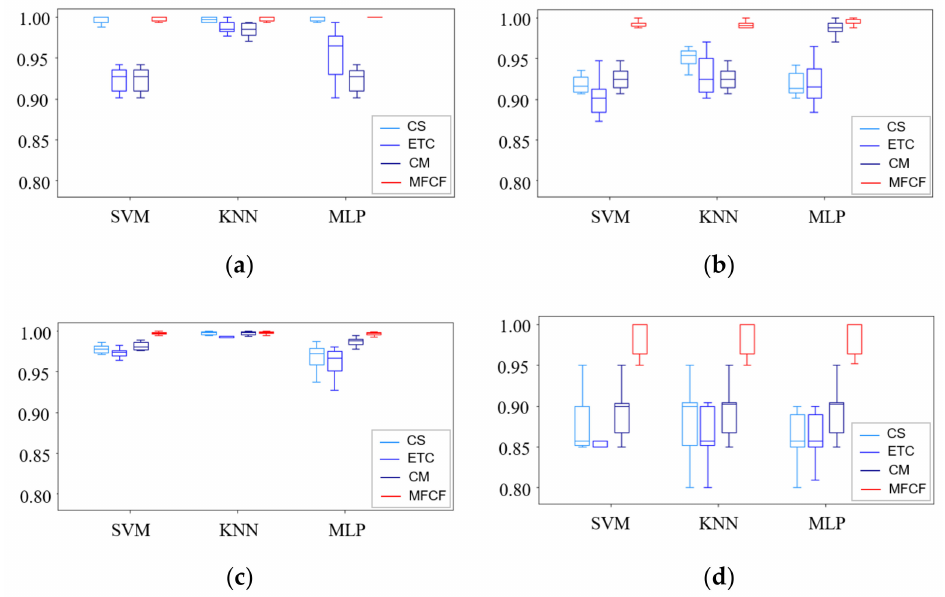
Figure 8. Ten-fold cross validation. ( a ) case 1; ( b ); case 2; ( c ) case 3; ( d ) case